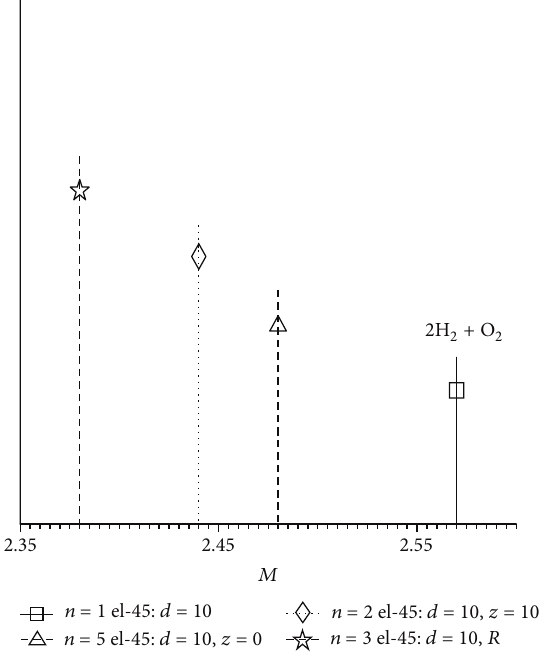
Figure 20: The critical (lowest) Mach number for excitation of a detonation at interaction of an incident SW with various reflectors: identical mixture conditions and variation of SW Mach number for individual reflector. The area from the right of vertical line corresponds to successful initiation (“go”, “yes”), from the left to unsuccessful initiation (“no go”).